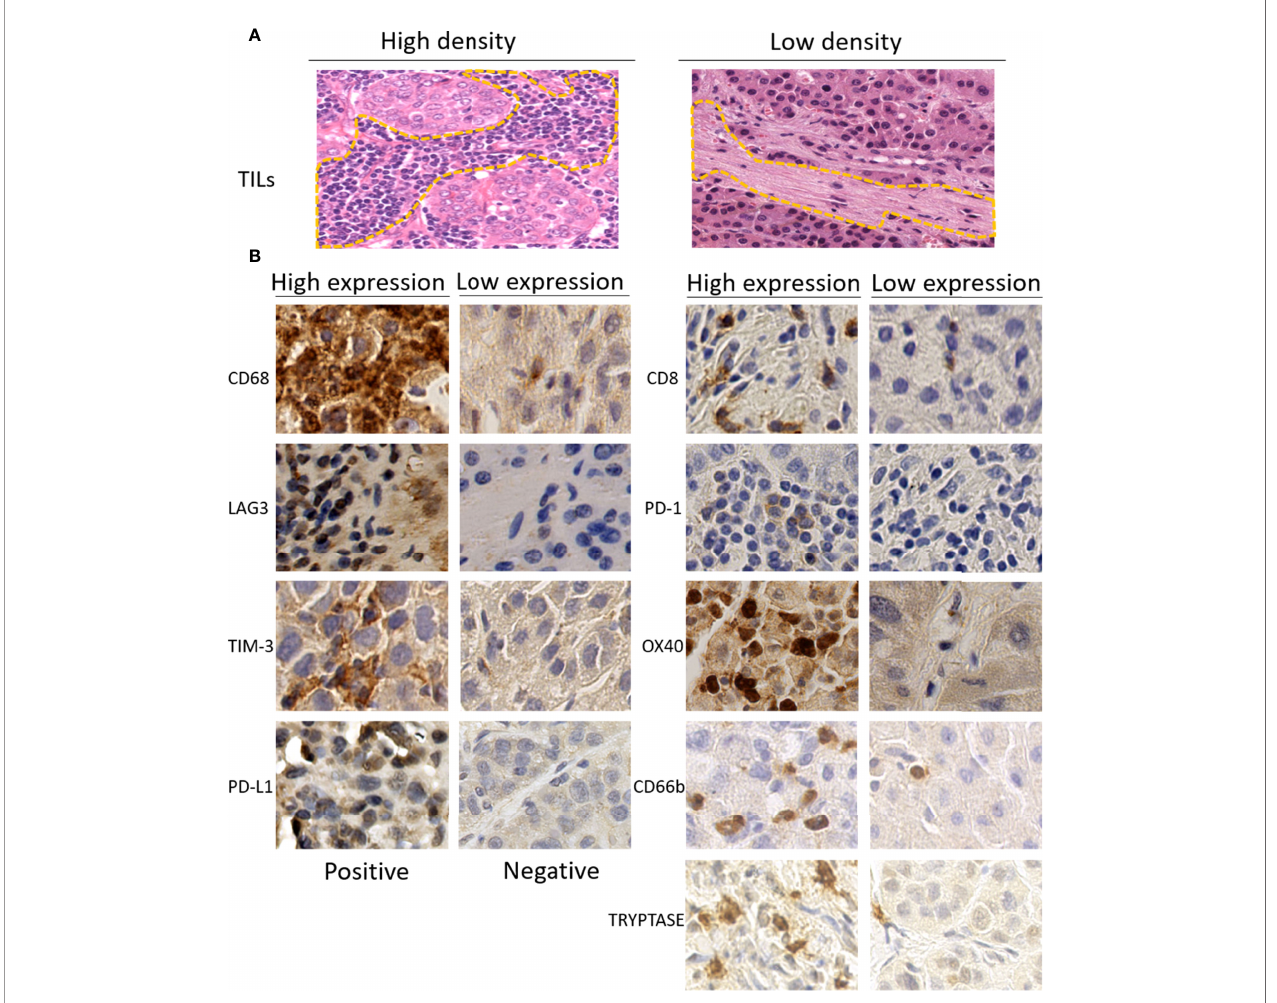
FIGURE 1 | (A) Representative images of high (left) or low (right) density of tumor-in fi ltrating lymphocytes (TILs) in the stromal of hepatocellular carcinoma on H&E- stained tumor sections (×100). (B) Representative immunohistochemistry images of high (left) or low (right) expression of immune-related biomarkers (×400). TILs, tumor-in fi ltrating